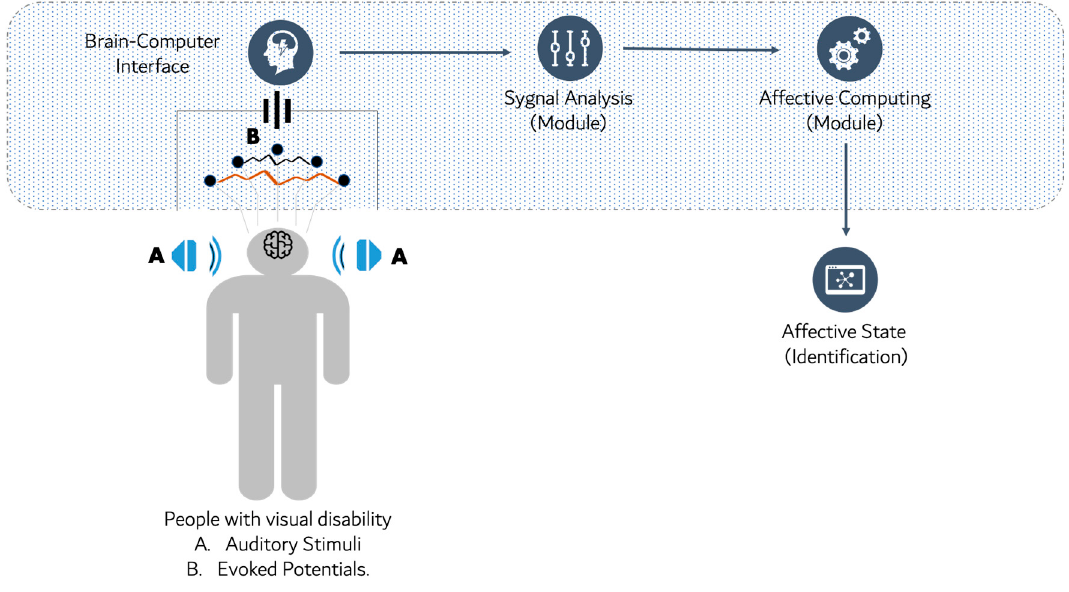
Figure 3. Integration of a BCI and AC for the detection of emotions in people with a visual disability.